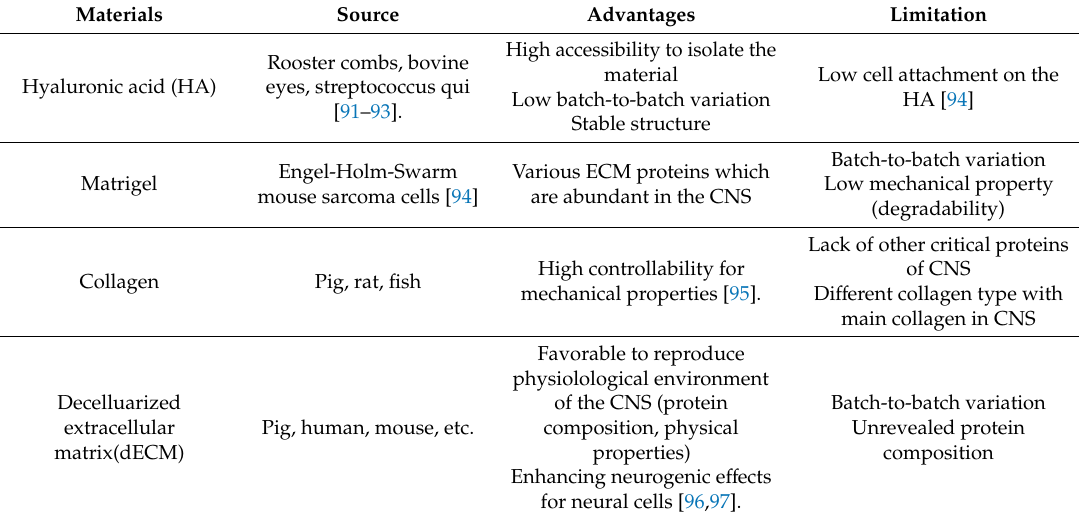
Table 1. Natural source derived matrix for neural